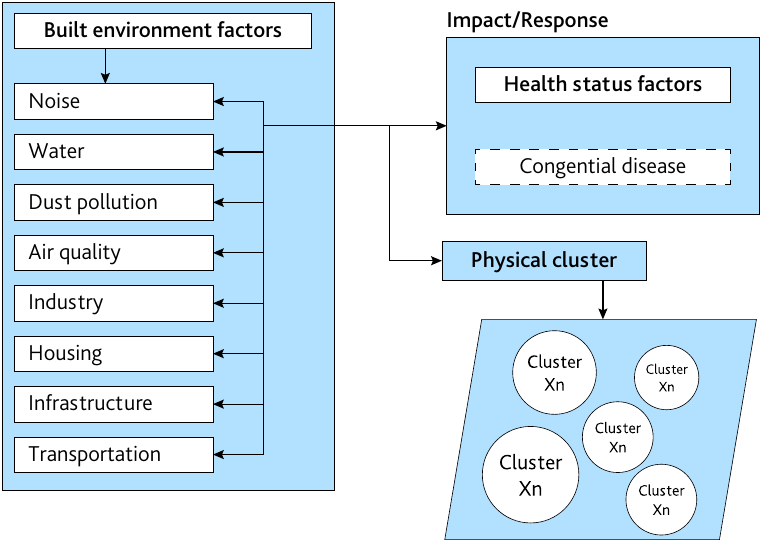
Figure 2. Framework of